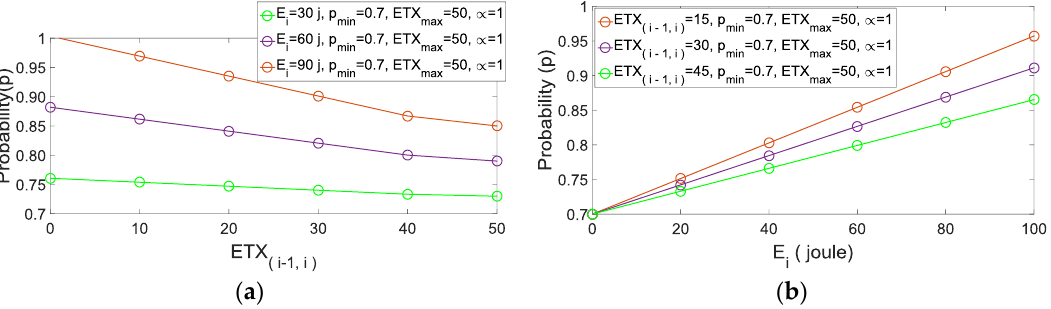
Figure 15. Representation of equation 14: ( a ) forwarding probability of a node via 𝐸𝑇𝑋 (𝑖−1,𝑖) ; ( b ) forwarding probability via residual energy of node i .